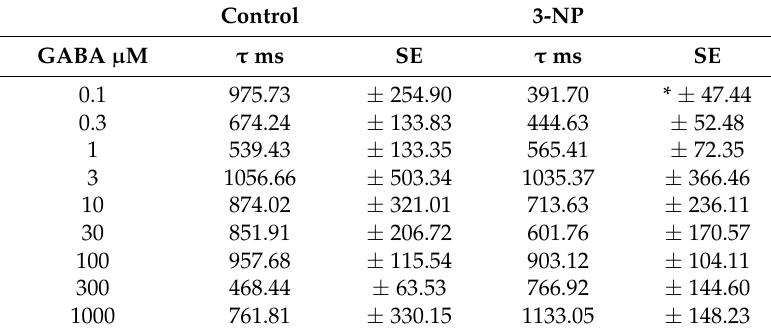
Table 1. Time constant of desensitization.